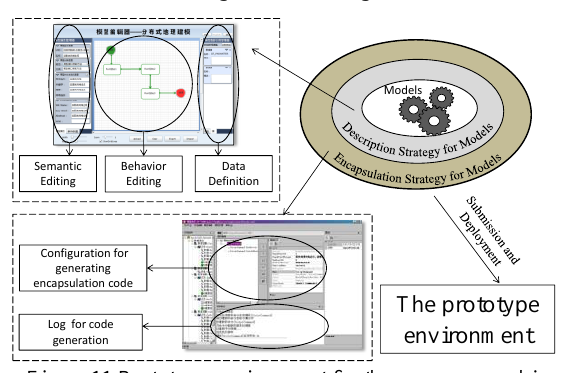
Figure 11 Prototype environment for the open geographic model sharing architecture